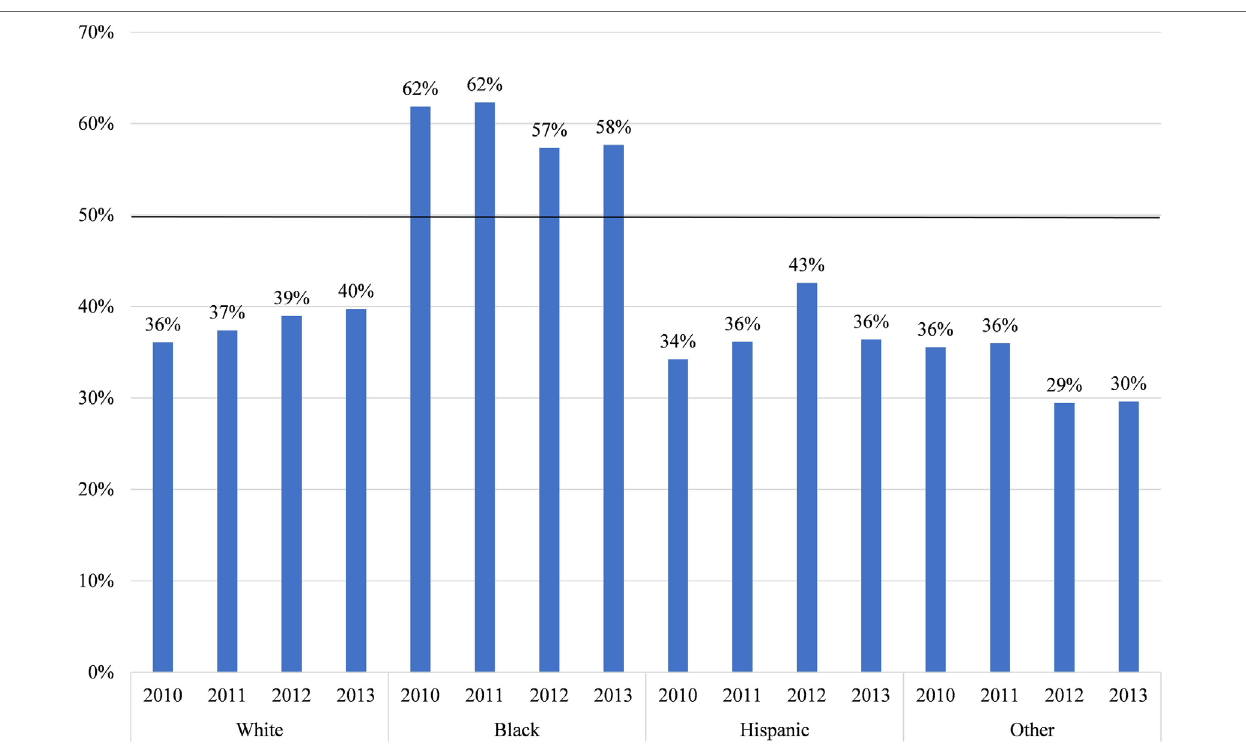
FigUre 6 | Proportion living in counties with below median rate of dentists per 100,000, by race, in Maryland